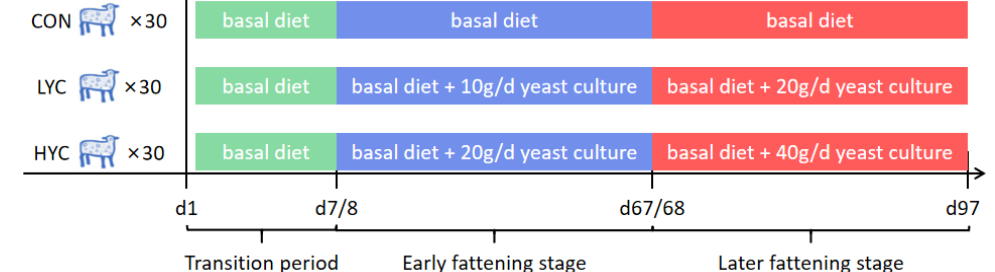
Figure 1. The frame diagram of experimental design. CON, control (basal diet supplied with 0 g/d yeast culture at the whole stage); LYC, low dose yeast culture (basal diet supplied with 10 and 20 g/d yeast culture at the early and late stages, respectively); HYC, high dose yeast culture (basal diet supplied with 20 and 40 g/d yeast culture at the early and late stages, respectively).